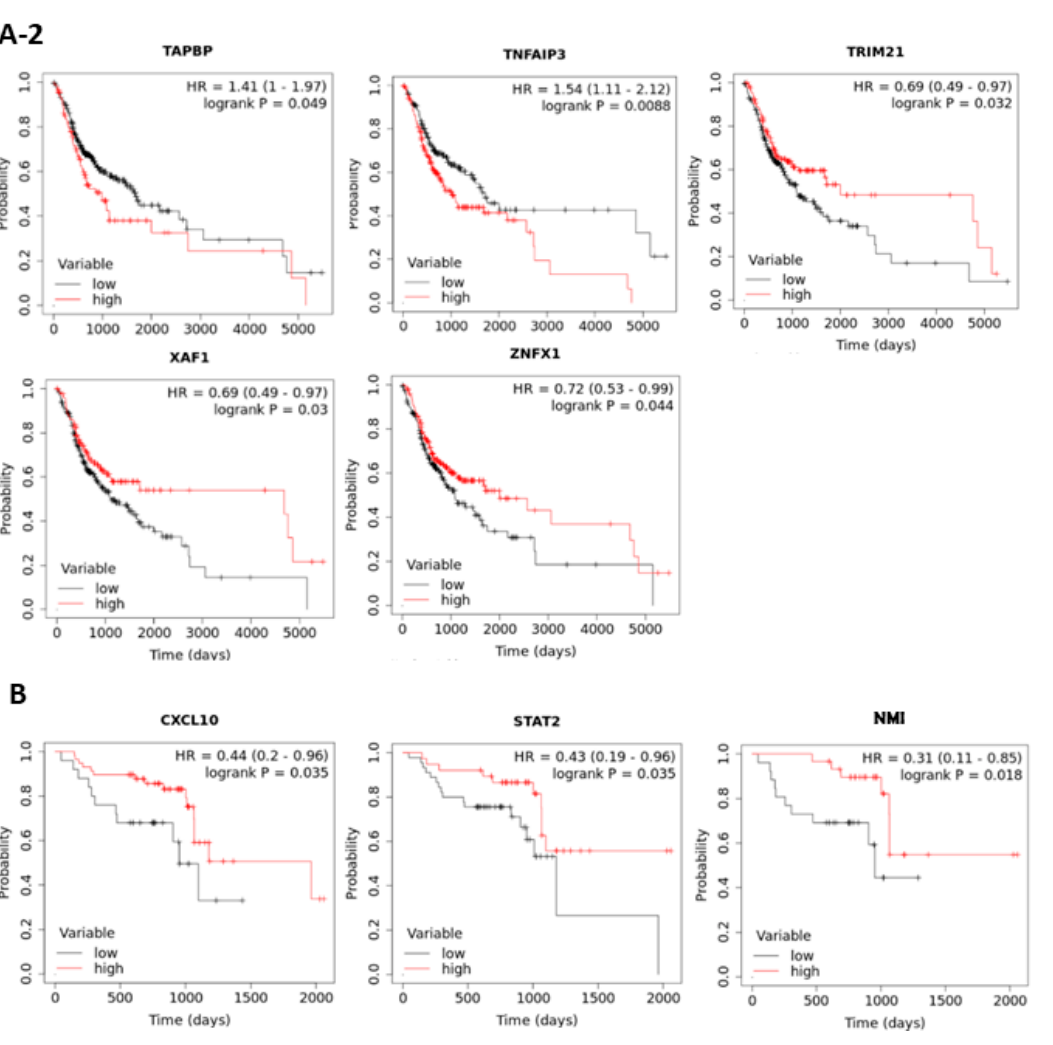
Figure 4. Kaplan-Meier plots of overall survival based on the expressions of interferon pathway genes in TCGA ( A - 1 , A - 2 ) and GSE65858 ( B ) oral cancer cohorts. The best cut-off values were computed using ROC curve analysis on the Kaplan-Meier plotter (http://kmplot.com/analysis/ accessed between 15 November 2020 and 4 April 2021) online tool. Only the plots with p < 0.05 in TCGA (17 out of the 43 genes) and GSE65858 (3 out of the 17 significant genes in TCGA) data sets are shown.